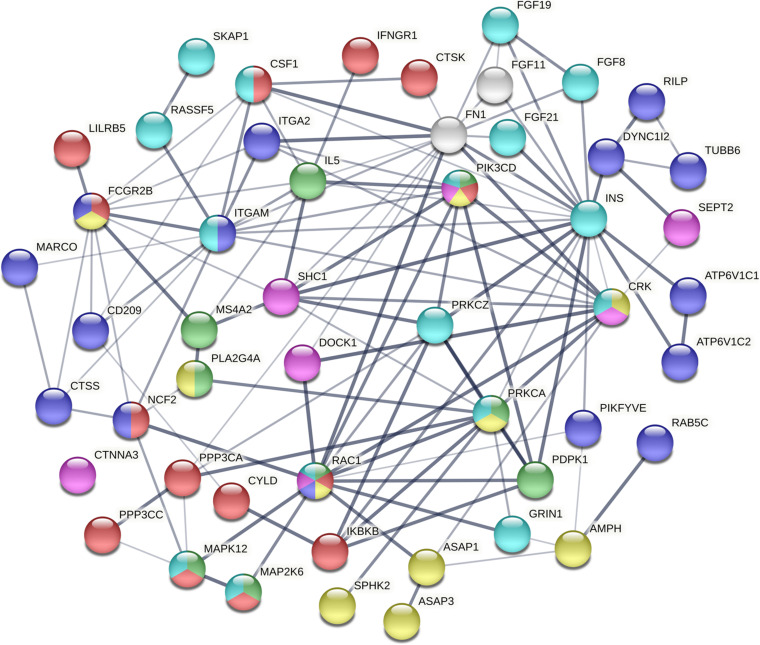
The interaction of mutated genes in SAPHO associated pathways identified in this study. The mutated genes of different pathways are shown by different colors. Each color represents a unique pathway and line thickness indicates the strength of data support (red, osteoclast differentiation; purple, phagosome; green, Fc epsilon RI signaling pathway; yellow, Fc gamma R-mediated phagocytosis; pink, Bacterial invasion of epithelial cells; blue, Rap1 signaling pathway).